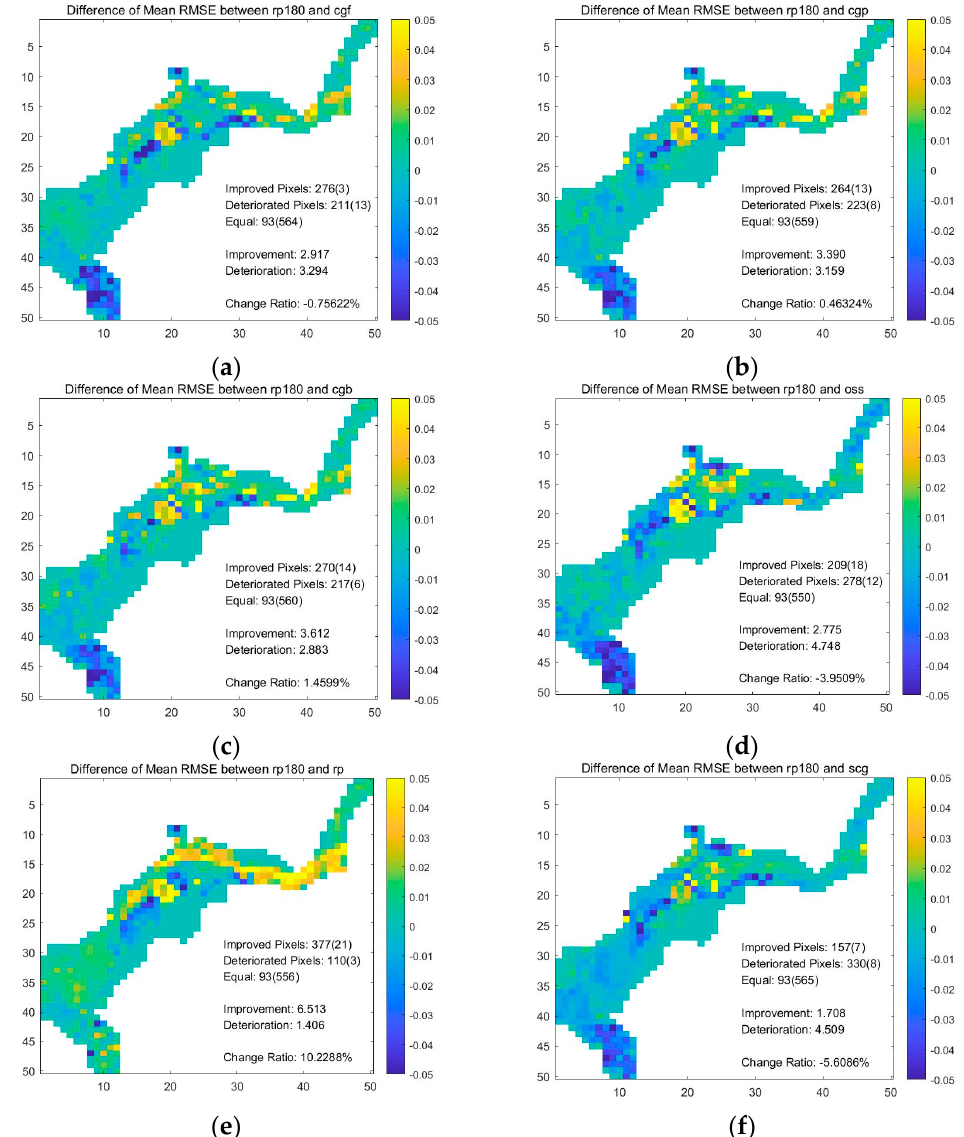
Figure A1. ( a ) Difference of mean RMSE on testing dataset between the set of RP (SD) and CGF ANN; ( b ) difference of mean RMSE on testing dataset between the set of RP (SD) and CGP ANN; ( c ) difference of mean RMSE on testing dataset between the set of RP (SD) and CGB ANN; ( d ) difference of mean RMSE on testing dataset between the set of RP (SD) and OSS ANN; ( e ) difference of mean RMSE on testing dataset between the set of RP (SD) and RP ANN; and ( f ) difference of mean RMSE on testing dataset between the set of RP (SD) and SCG ANN.